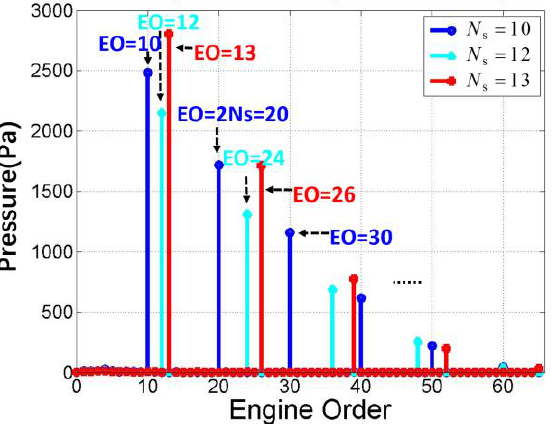
Figure 7. Frequency spectrum of monitoring point pressure at the leading edge of the rotor.